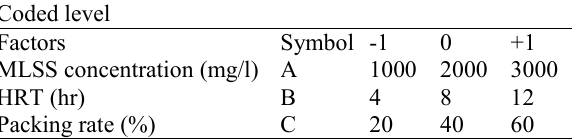
Table 1. Variables and study range based on response surface methodology (RSM) Coded level